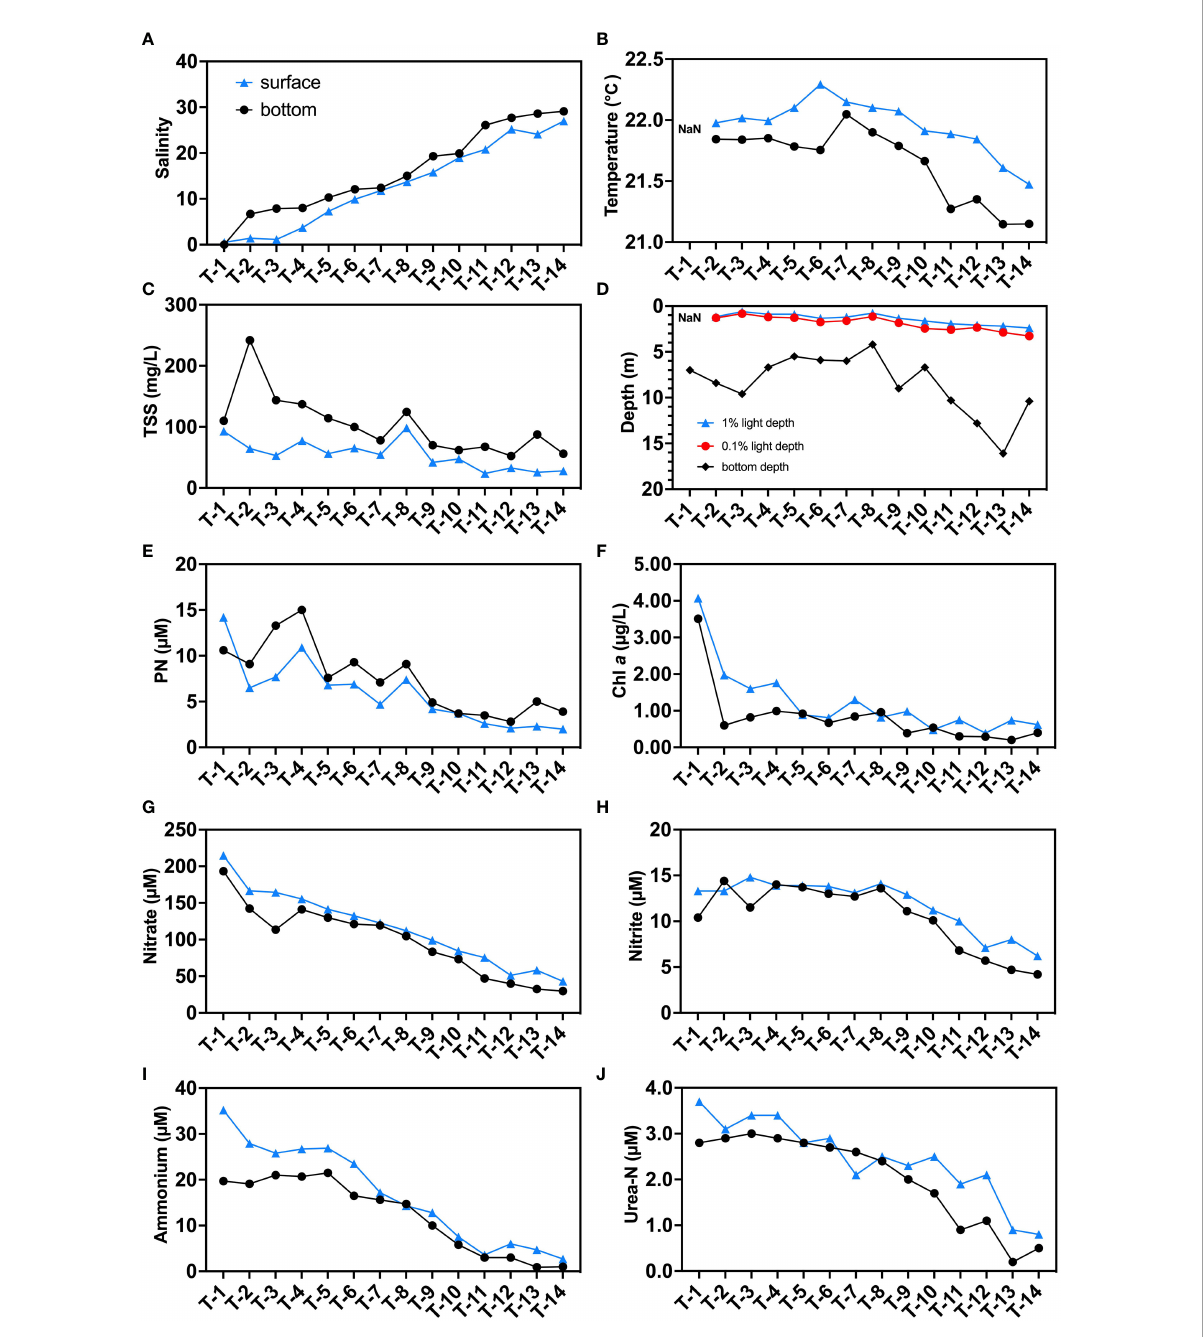
FIGURE 2 Distributions of environmental parameters in the sampling stations: (A) salinity; (B) temperature (°C); (C) total suspended substances (TSS, mg/L); (D) 1% surface light depth, 0.1% surface light depth, and bottom depth (m); (E) particulate N (PN, m M); (F) Chl a ( m g/L); (G) nitrate ( m M); (H) nitrite ( m M); (I) ammonium ( m M); and (J) urea-N ( m M). Blue triangles indicate surface samples, black circles indicate bottom samples. “ NaN ” in sub fi gures (B) and (D) represent data that are not